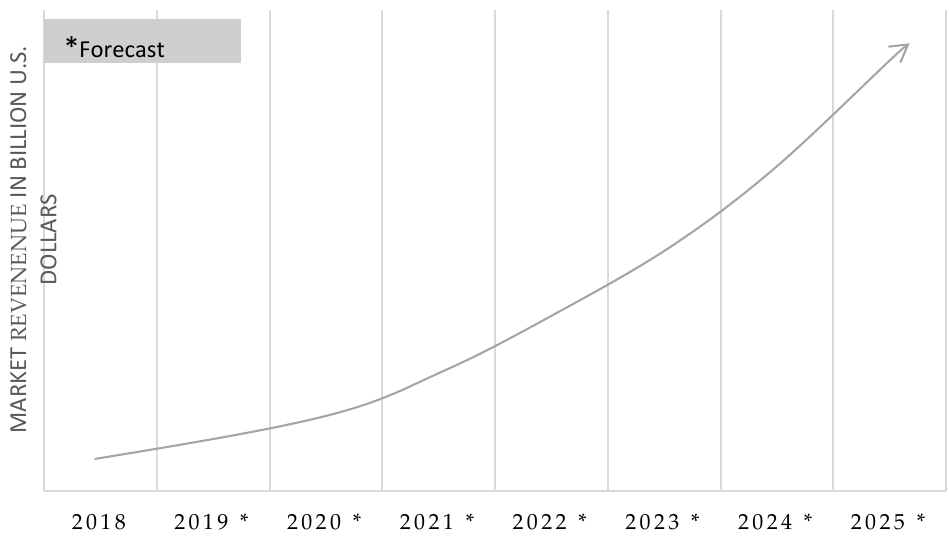
Figure 3. Revenues from the artificial intelligence (AI) market worldwide from 2018 to 2025. Data source: [42].